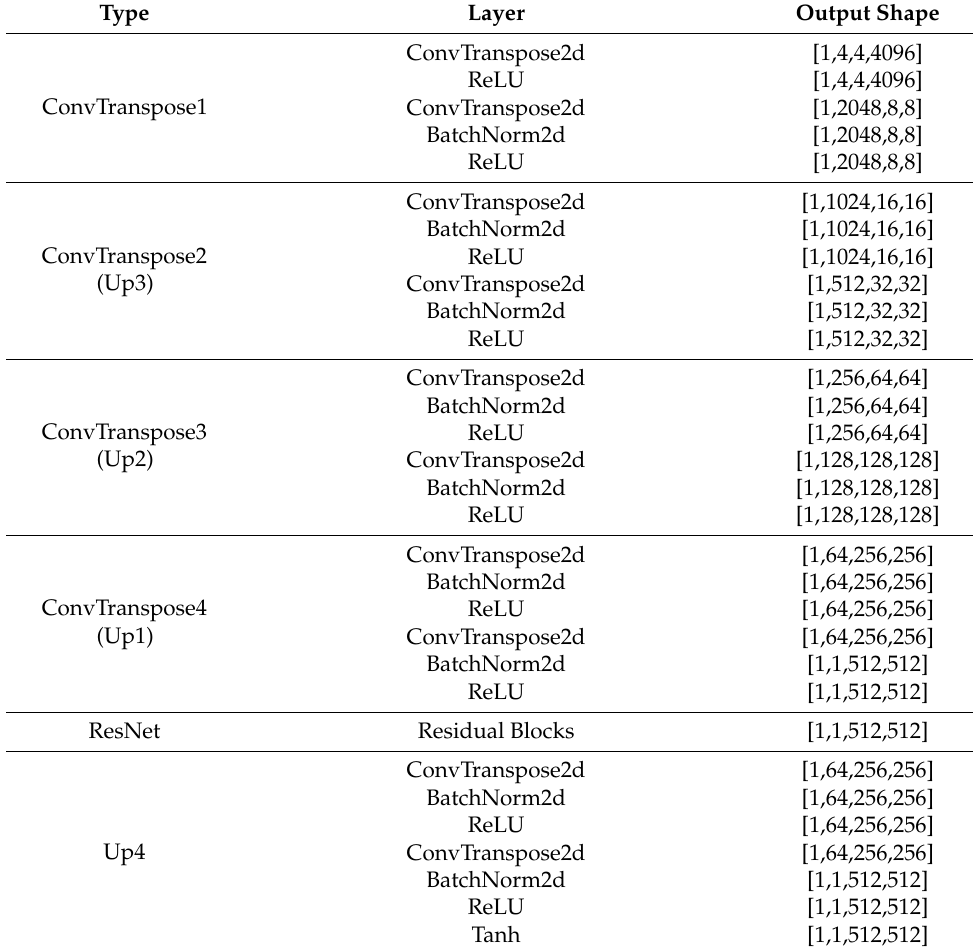
Table 1. The framework of generator model.